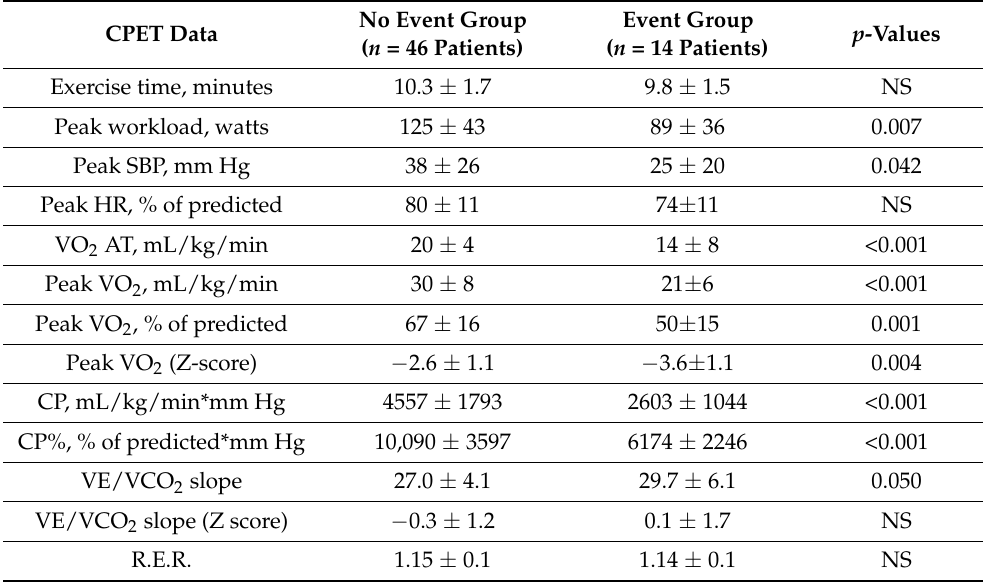
Table 4. Comparison between the main CPET variables between HCM patients who did not experi- ence (No Event Group) or experienced (Event Group) adverse